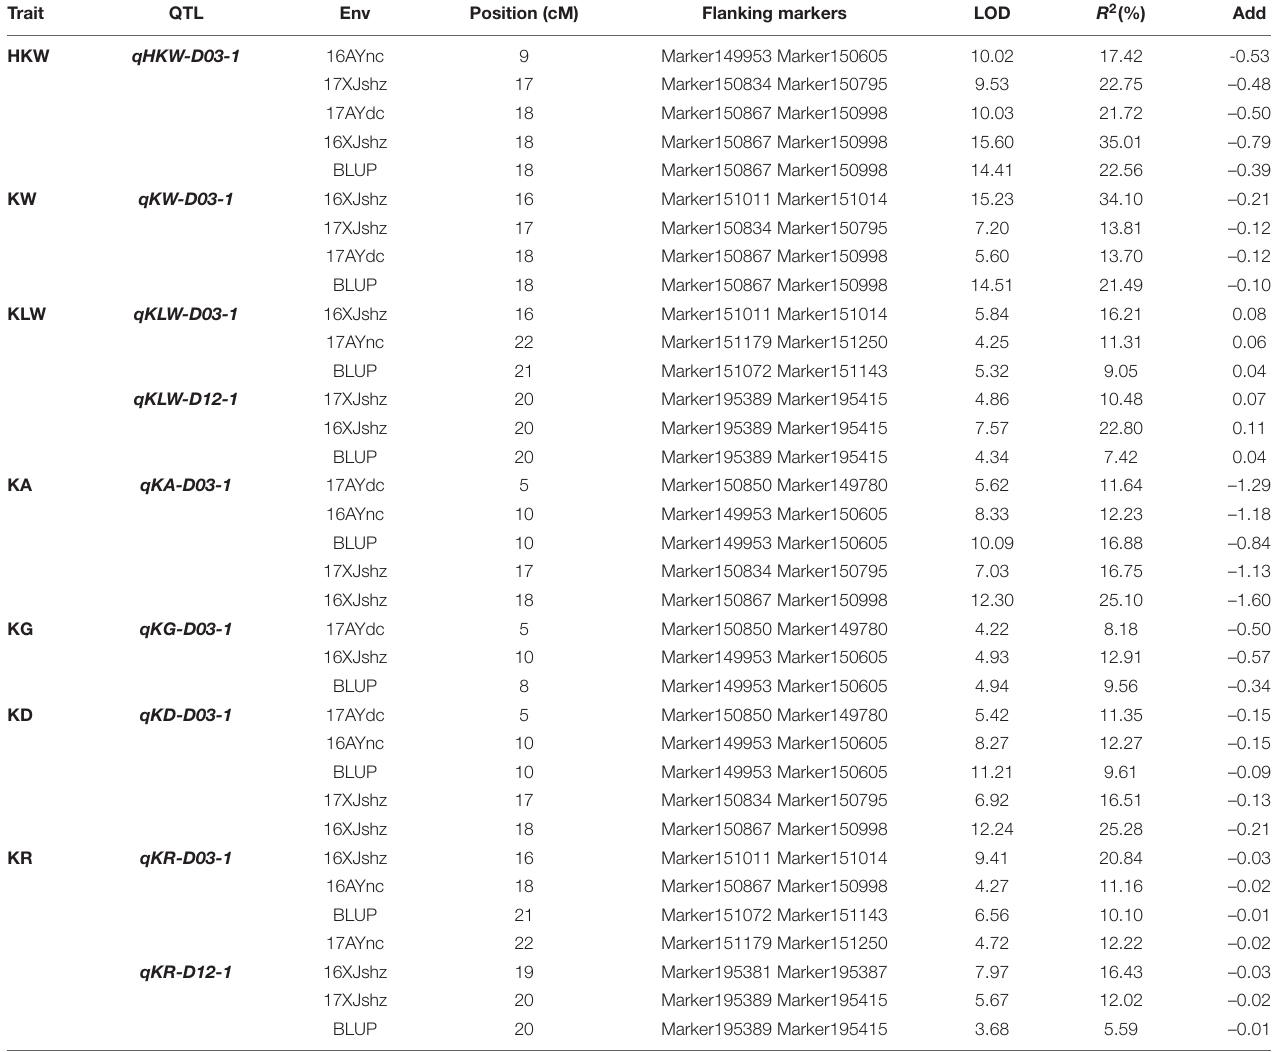
TABLE 3 | Stable quantitative trait loci (QTLs) for cottonseed physical traits identified in five environments and BLUP.